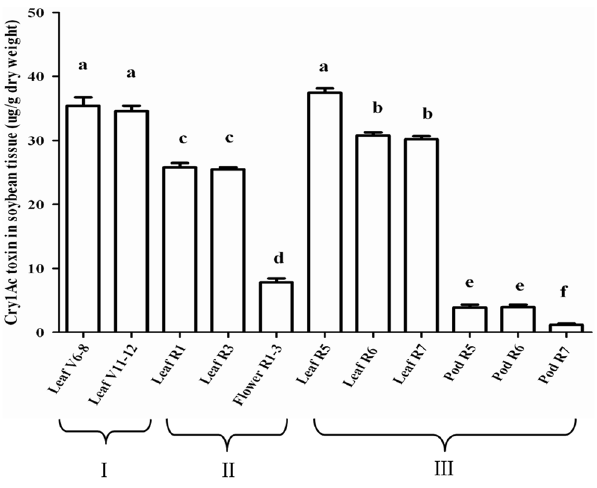
Figure 1. Cry1Ac toxin concentrations ( m g/g dry weight, mean + SE) in plant tissues of Bt soybean from the field. Samples were taken before (I), during (II) and after anthesis (III) (n=6). Bars with different letters are significantly different at P , 0.05.